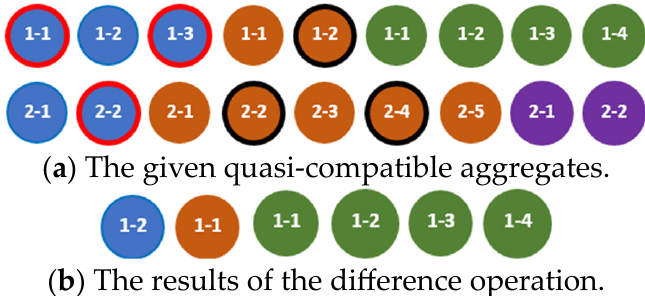
Figure 10. An example of applying the di ff erence operation to two compatible aggregates.